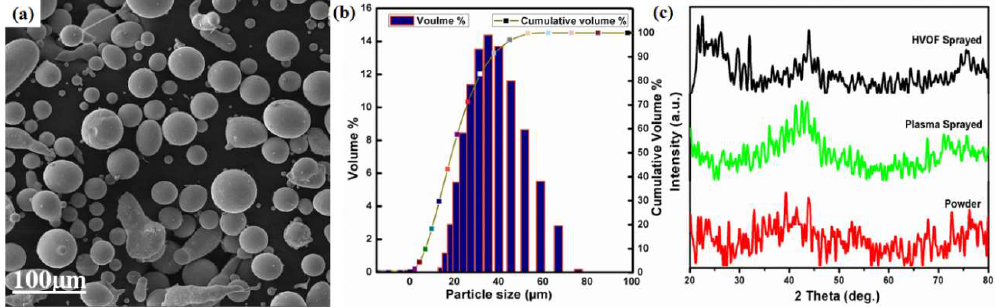
Table 2. High-velocity oxy-fuel (HVOF) spraying parameters.